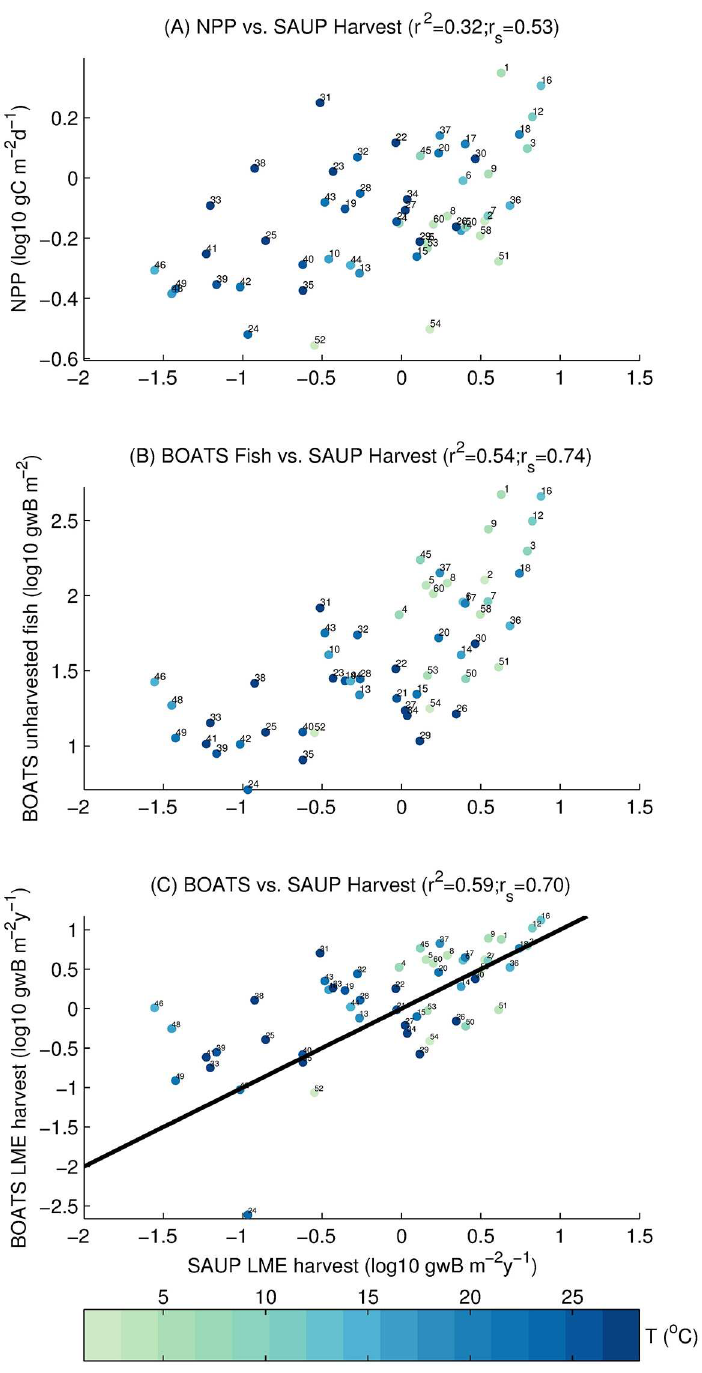
Fig 6. SAUP reconstructed harvestas described by primary production, modelled unharvested biomass, and modelled harvestat the LME scale. Correlationsare for the model variant from the Monte Carlo simulationthat best represents the SAUP database.The circle color represents the average temperature of the LME, whereasthe number represents the LME number (S3 Table). All quantitiesare plotted in log10 space to improve readability. r 2 is the squaredPearson product-moment correlation coefficient,and r s is Spearman’srank correlation. All 6 correlationshave a p -value < 0.01. (A) NPP vs. SAUP harvest. (B) Modelledunharvested biomass vs. SAUP harvest. (C) Modelledharvest at peak harvest state vs. SAUP harvest. The black line is the identity line (1:1